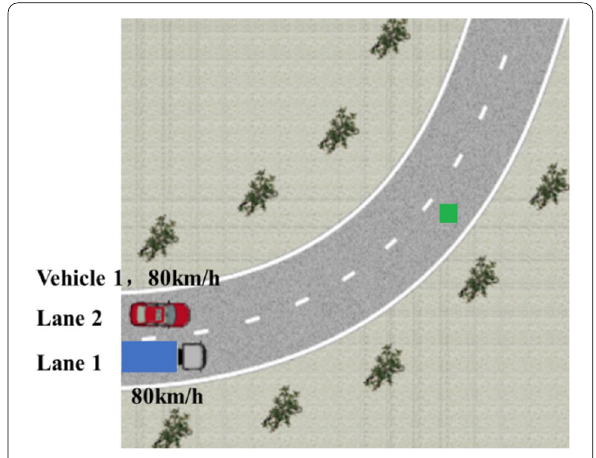
Figure 9 Vehicles and obstacle in Scenario 2